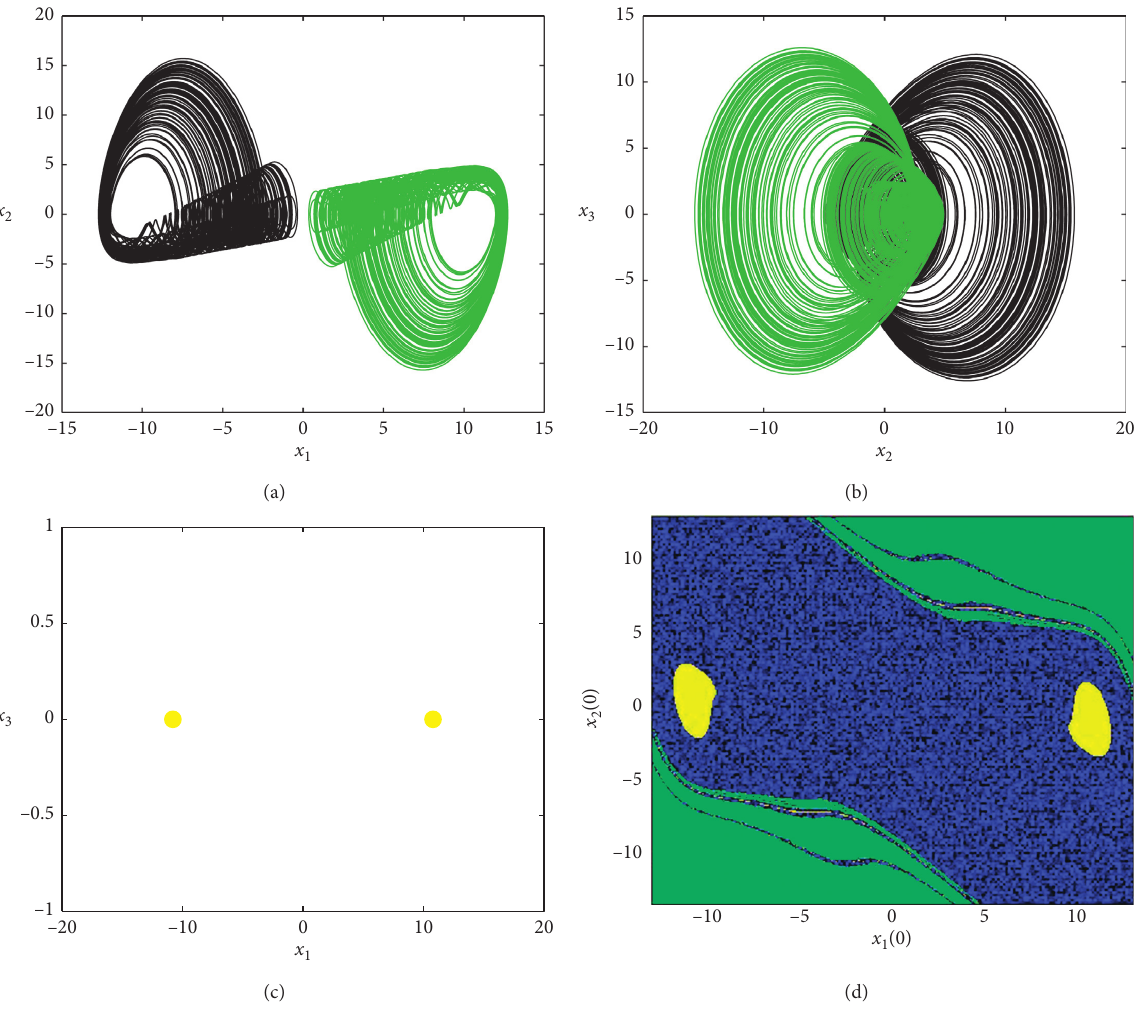
− x − x and x plans), (c) a pair of 1 2 2 3 ( 0 ) , x ( 0 ) , x ( 0 ) , x ( 0 )) are, 1 2 3 4